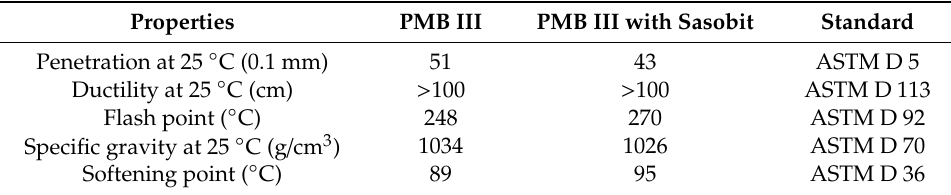
Table 2. Physical properties of Polymer Modified Bitumen (PMB) III and PMB III with Sasobit.